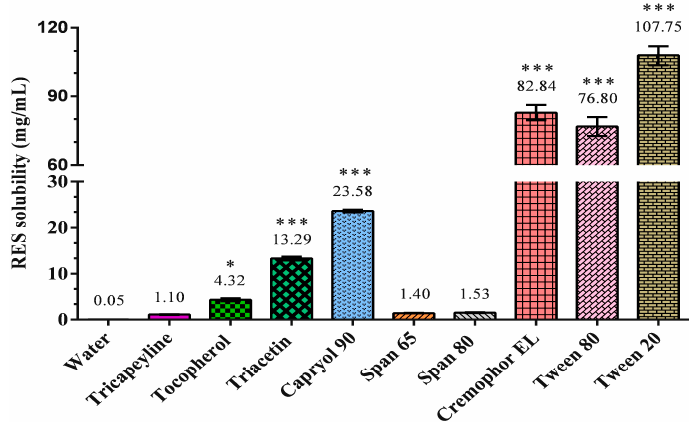
Figure 1. Solubility of resveratrol (RES) in different solvents. Results were expressed as mean ± standard error of the mean ( n = 3 for each group). * p < 0.05 compared with water group. *** p < 0.001 compared with water group.